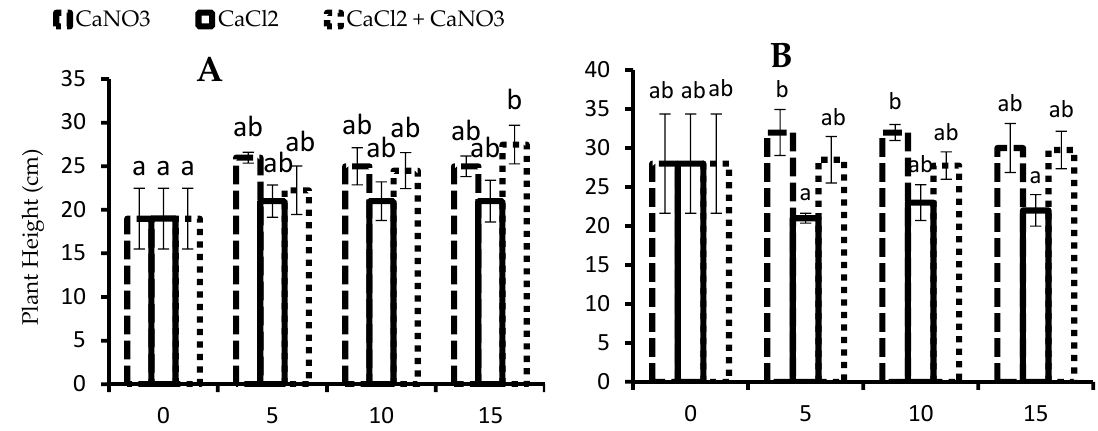
Figure 3. Plant height of the Shenkola ( A ) and Gera ( B ) potato varieties supplied with CaNO 3 alone, CaCl 2 alone, and CaNO 3 mixed with CaCl 2, provided at 0 (control), 5, 10, and 15 g per plant. Error bar represents ± SE from four replicates. Different small letters indicate significant difference between treatments ( p < 0.05).